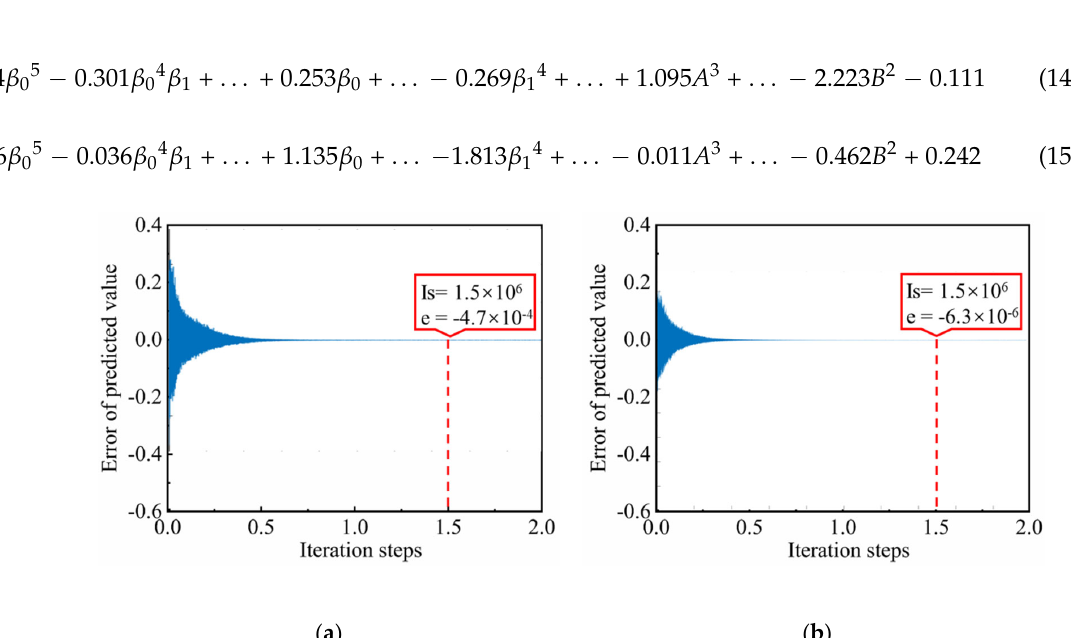
Figure 9. The variation in prediction error with iteration steps: ( a ) total pressure training error; ( b ) efficiency training error